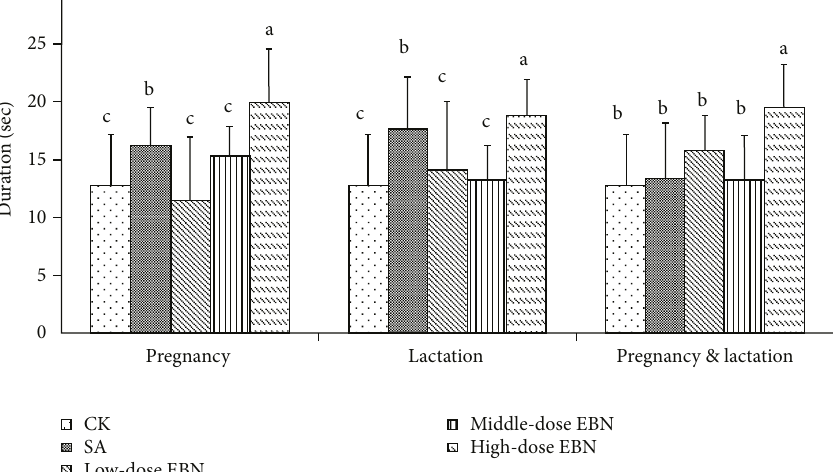
Figure 5: Time duration of 10 cubs from each group staying in the third quadrant after treated with edible bird ’ s nest (EBN) homogenate. Signi fi cant di ff erences were indicated by di ff erent letters for each group ( P < 0 05